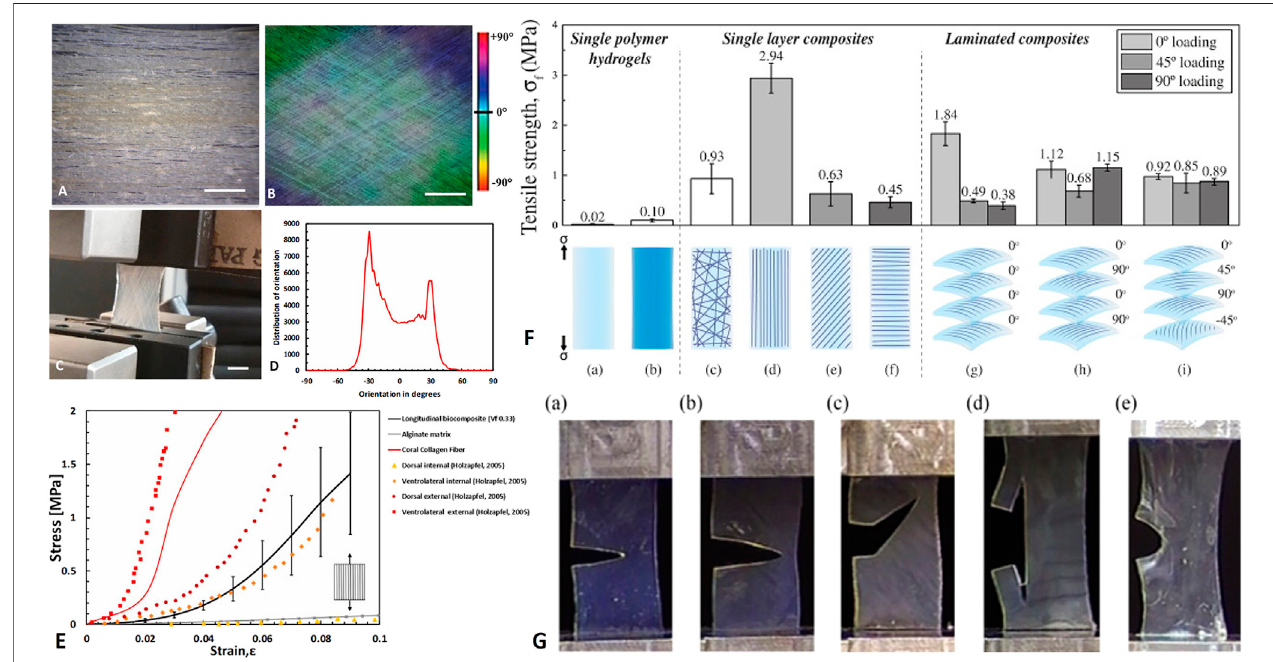
FIGURE11| Biomimeticsofsoftcomposite fi brousstructures. (A – E) biomimeticsofformandfunctionofannulus fi brosuslamellaeusingcollagenreinforcealginate hydrogel composite. (A) Longitudinal arrangement of collagen fi bers (B) Angle – plied (AP) arrangement of collagen fi bers ( ± 30 ° ). (C) AP biocomposite under uniaxial tensiontest (D) Distributionofcollagen fi berorientationsintheAPbiocomposite(scalebar5 mm). (E) Mechanicalbehavioroflongitudinalbiocomposites,alginatematrix, and representative coral collagen fi ber in comparison with in vitro uniaxial AF Single lamella measurements of (Holzapfel et al., 2005). Reprinted from Sharabi et al. (2019) with permission. (F) Electrospun gelatin nano fi bers embedded in alginate hydrogel composites: Tensile failure strength σ f (a) alginate and (b) gelatin; single layer composites: (c) random fi ber composite, (d) longitudinal laminate, (e) 45 ° laminate, (f) 90 ° laminate; and four-layer laminate composites with a (g) uniaxial 0 ° /0 ° /0 ° /0 ° fi bre orientationpattern,(h)cross-ply0 ° /90 ° /0 ° /90 ° fi berorientationpattern,oran(i)angle-ply0 ° /45 ° /90 ° / − 45 ° fi berorientationpattern. (G) Crackpatternsinalginatehydrogels with (a) no fi bers, (b) 90 ° laminate, (c)) 45 ° laminate, (d) longitudinal laminate, and (e) cross-ply 0 ° /90 ° /0 ° /90 ° composite. (F – G) Reprinted from Tonsomboon et al. (2017) under